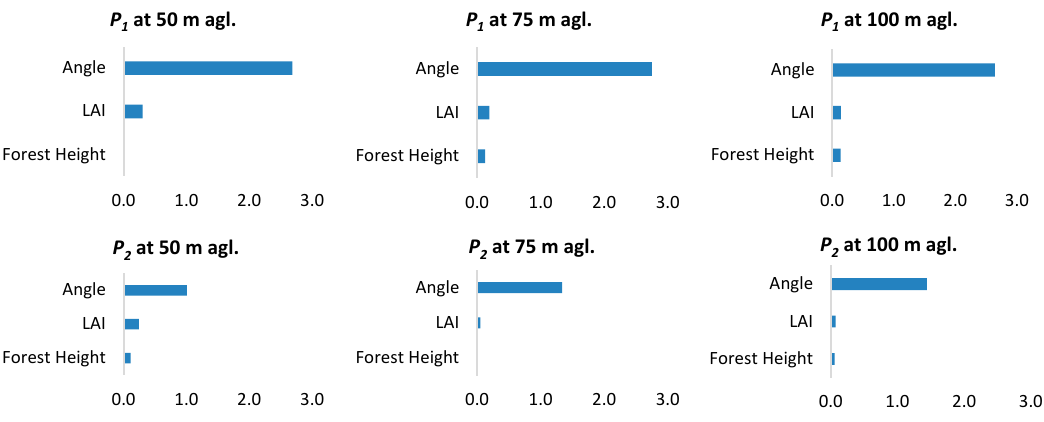
Figure 7 . Pareto chart of effects for the flow inclination angle at different altitudes on 𝐿 1 and 𝐿 2 .